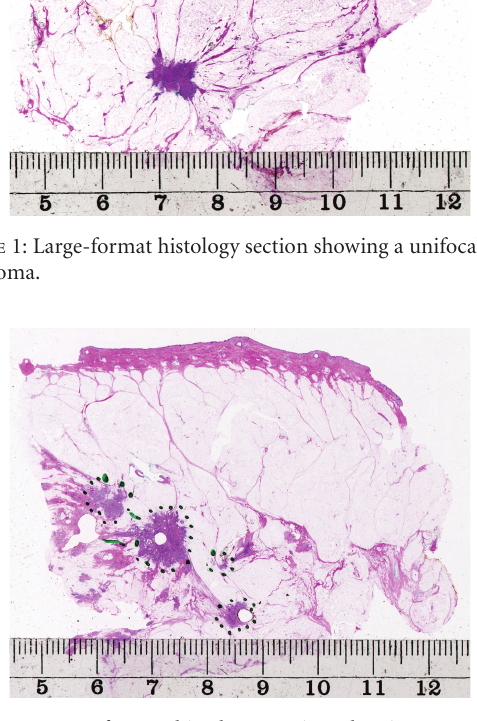
Figure 2: Large-format histology section showing a multifocal breast